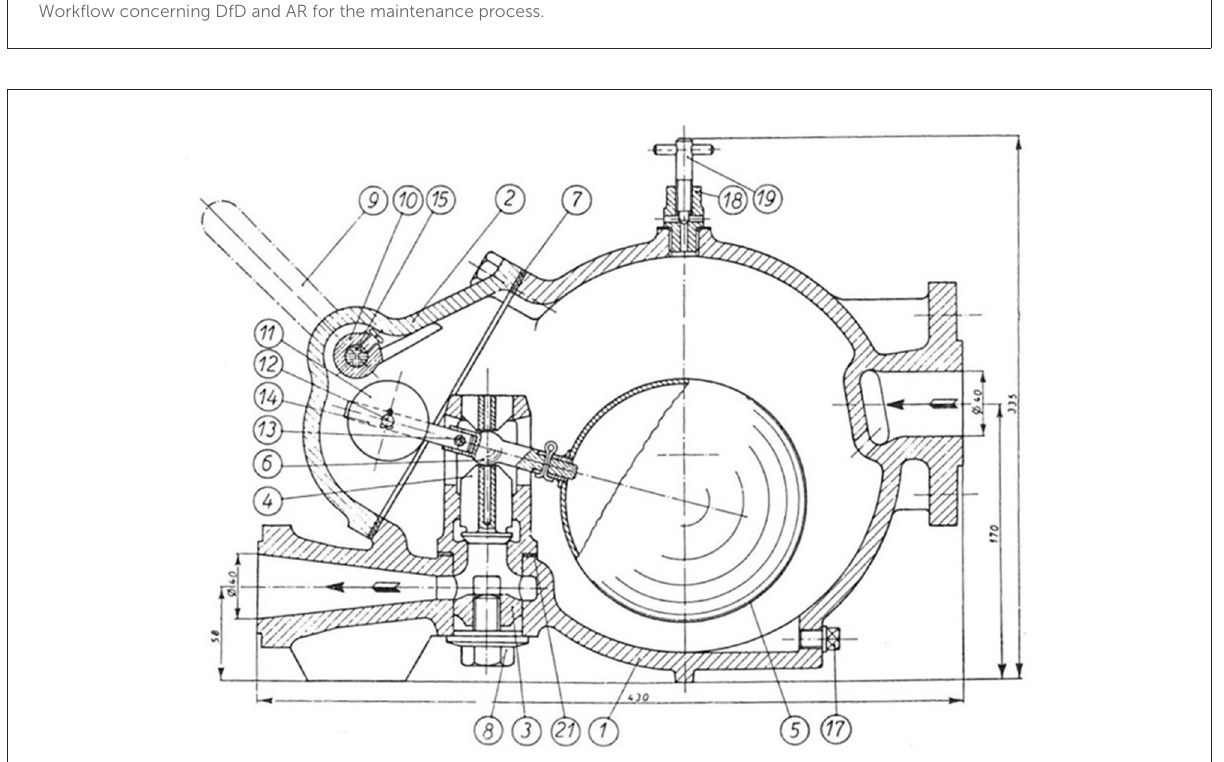
FIGURE2 Drawing of the assembly (not all BOM components are